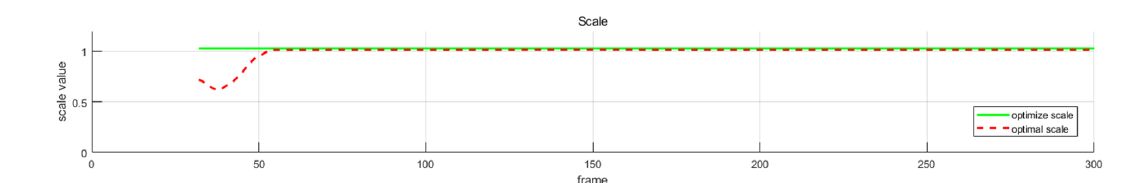
Figure 9. The optimized scale variable for the sequence MH (Machine Hall) 01. The optimal scale value is computed by aligning the estimated visual trajectory with the ground-truth poses via Sim ( 3 ) [42]. Our bootstrapping algorithm estimates reliable initial scales within the 50th frame, then updates the local scale by Equation (26) incrementally. It can be verified that the estimated scales are very close to the optimal